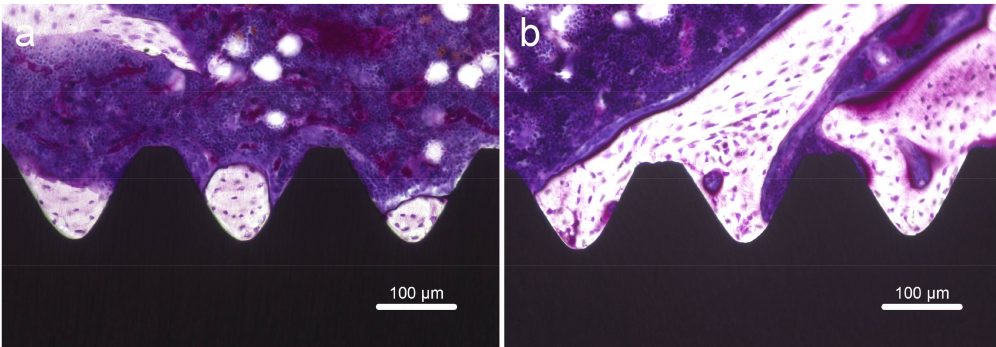
Figure 10. Villanueva staining of bone tissues around ( a ) Ti and ( b ) FHA-coated implants.